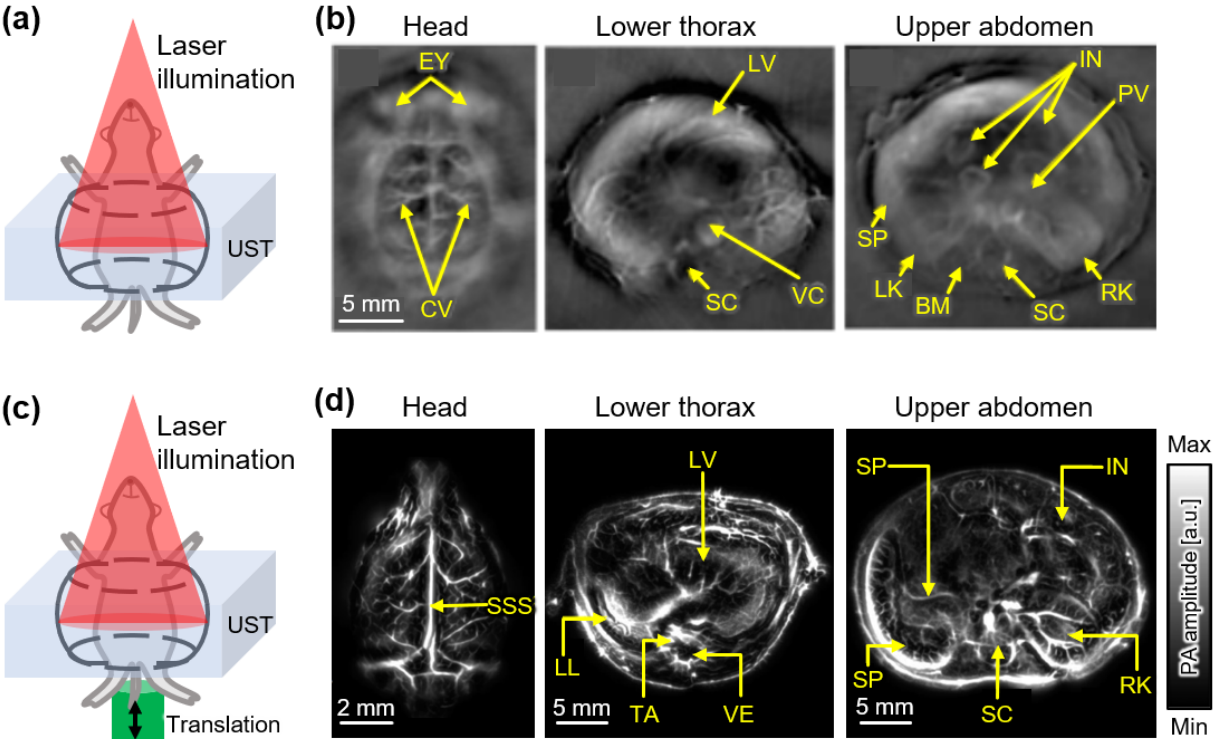
Figure 4. PAI systems with full ‐ ring array USTs. ( a ) Schematic of PAI system with a curved array UST. ( b ) Cross ‐ sectional PA images at the various positions of a mouse in vivo. ( c ) Schematic of PAI with a translational scan of mice for volumetric data acquisition. ( d ) Cross ‐ sectional PA images from the volumetric whole ‐ body image of a mouse in vivo. PA, photoacoustic; PAI, photoacoustic imag ‐ ing; UST, ultrasound transducer; EY, eyes; CV, cortical vessels; LV, liver; SC, spinal cord; VC, vena cava; SP, spleen; LK, left kidney; RK, right kidney; BM, backbone muscle; PV, portal vein; IN, intes ‐ tine; SSS, superior sagittal sinus; LL, left lung; TA, thoracic aorta; VE, vertebra. The images are re ‐ produced with permission from refs. [48,49].